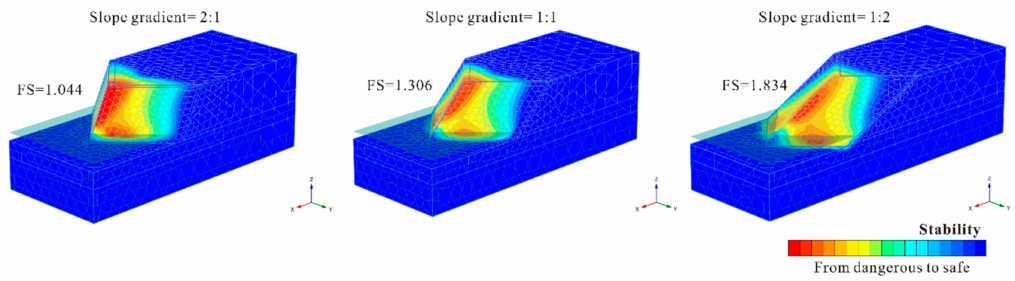
Figure 10. The di ff erence in failure mechanism between slopes with three gradients: turning corner equal to 90 ◦